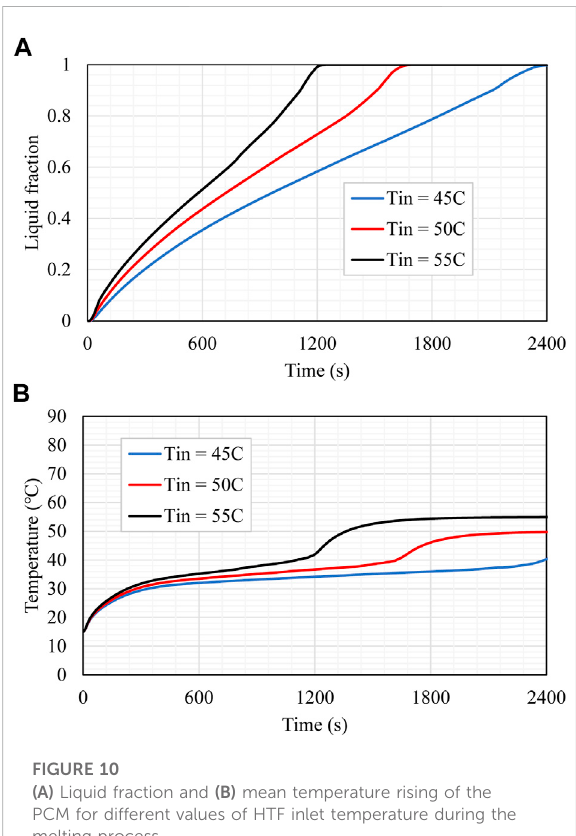
FIGURE 9 (A) Liquid fraction and (B) mean temperature rising of the PCM for different values of Re through the charging process.